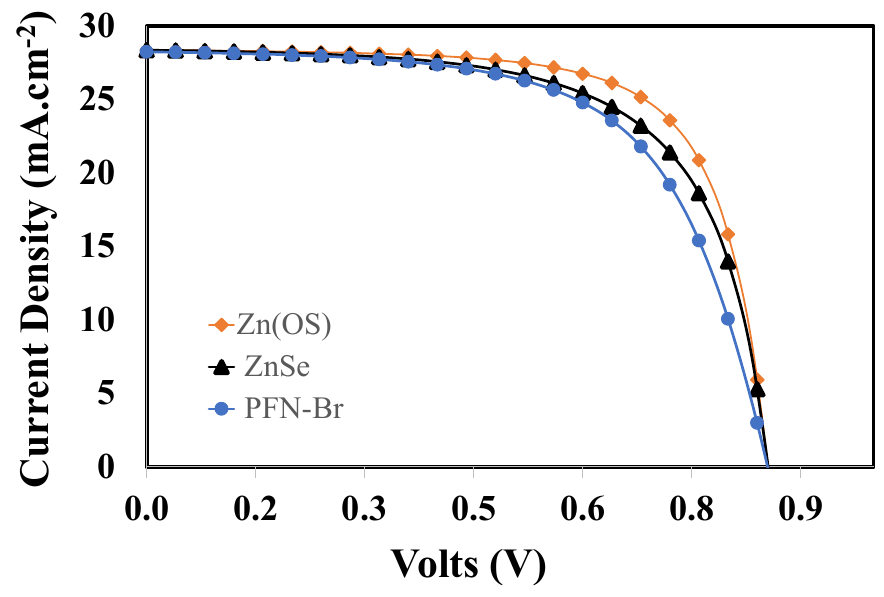
Figure 8. The overall photovoltage parameters of the optimized devices ITO/Zn(O,S)/PTB7:PC 70 BM/PEDOT:PSS/Au, ITO/ZnSe/PTB7:PC 70 BM/PEDOT:PSS/Au, ITO/PFN-Br/PTB7:PC 70 BM/PEDOT:PSS/Au, respectively. Table 2. The overall photovoltaic parameters for the optimized Zn(O,S), ZnSe, and PFN-Br devices.